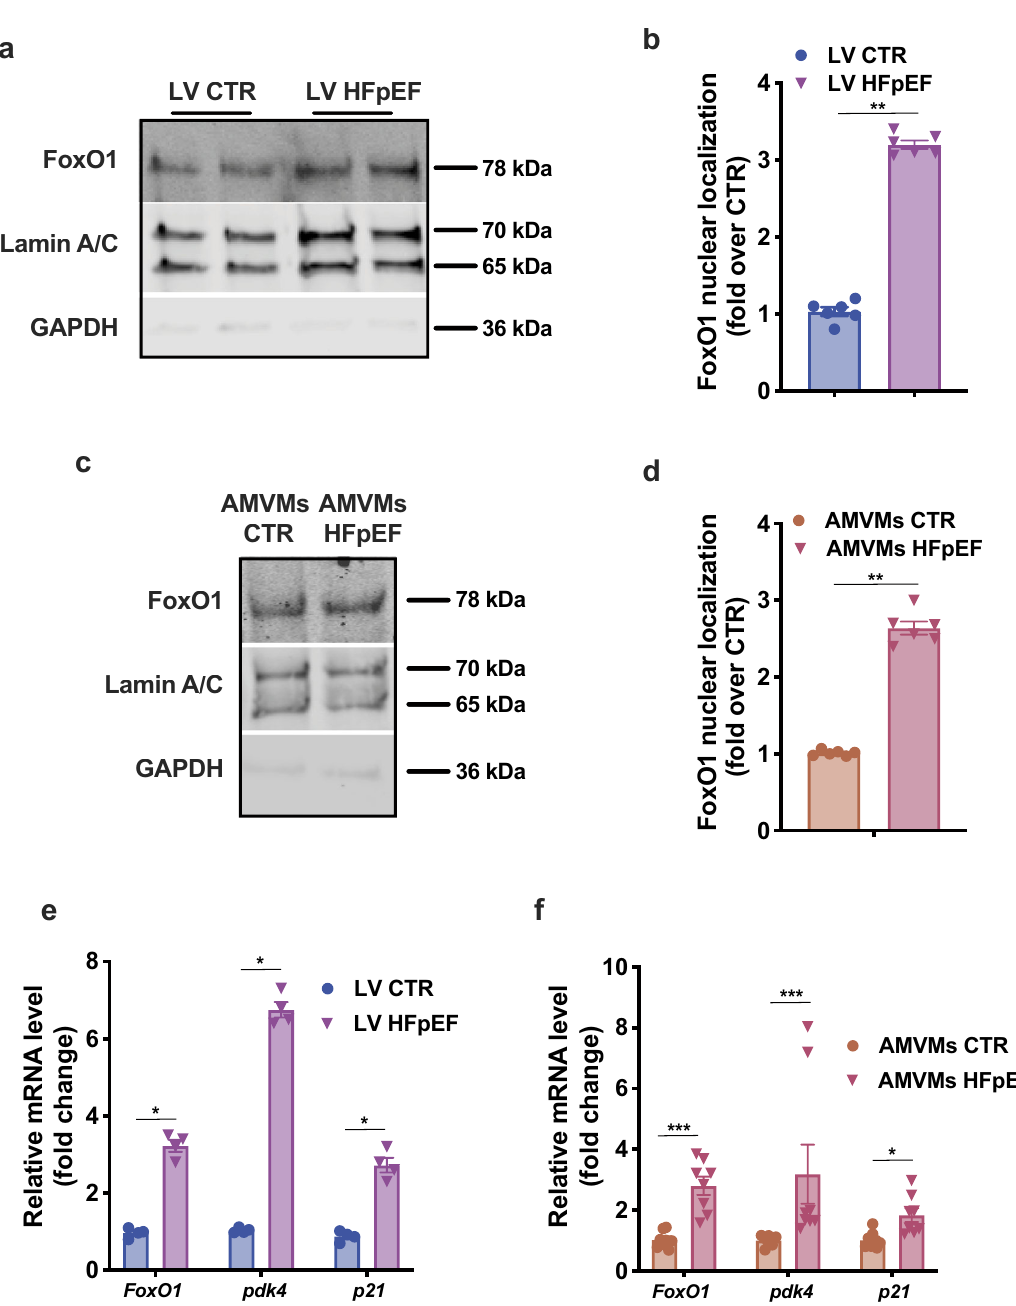
Fig. 2 FoxO1 activation in hearts and cardiomyocytes from HFpEF mice. a Representative immunoblot images of FoxO1, Lamin A/C, and GAPDH proteins in nuclear extracts from LV of CTR and HFpEF mice. Images are representative of six hearts/group. b Bar graphs depicting intensities of the nuclear FoxO1 protein band ( n = 6/group). c Representative immunoblot images of FoxO1, Lamin A/C, and GAPDH proteins in nuclear extracts from adult mouse ventricular myocytes (AMVMs) of CTR and HFpEF mice. Images are representative of six hearts/group. d Bar graphs depicting the nuclear FoxO1 protein band intensities ( n = 6/group). e mRNA levels of FoxO1 , pdk4 , and p21 in LV of CTR and HFpEF mice ( n = 4/group). f mRNA levels of FoxO1 , pdk4 , and p21 in AMVMs of CTR and HFpEF mice ( n = 8/group). Results are presented as mean ± S.E.M. In b , d , e , and f * p < 0.05, ** p < 0.005, *** p < 0.0005, unpaired, two-tailed Kolmogorov – Smirnov